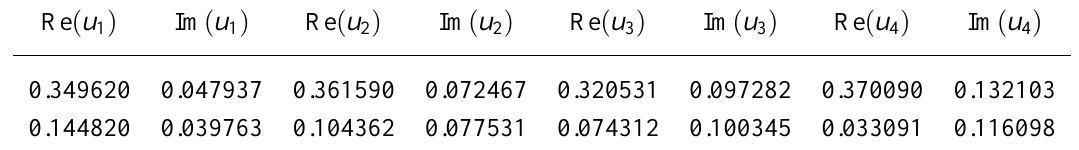
-Gly -Ala . 10 10 5